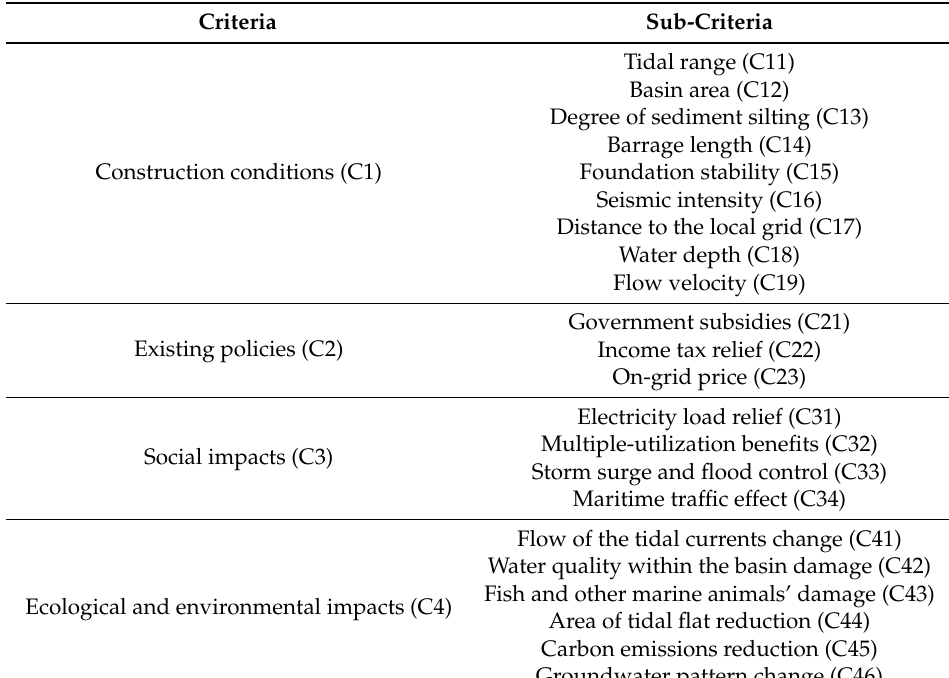
Table 2. The criteria and sub-criteria for TPP site